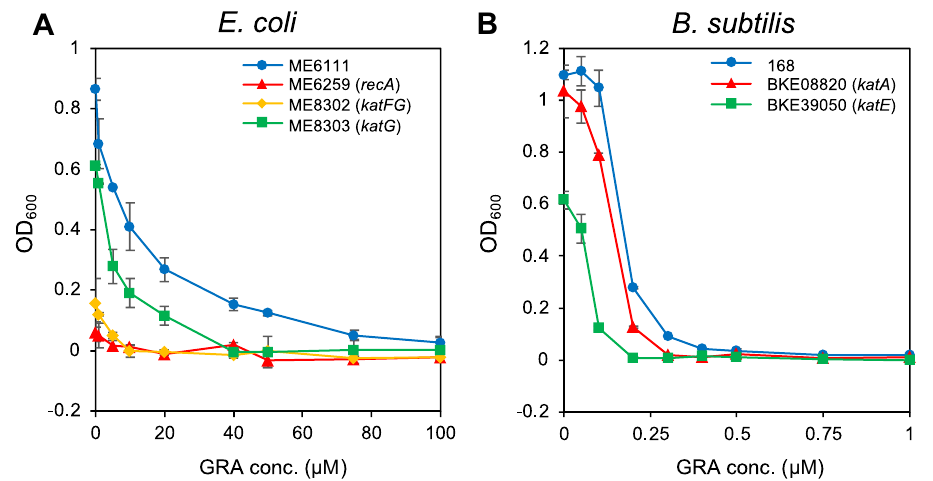
Figure 7. Inhibition of bacterial growth by granaticin. Growth inhibition of E. coli ( A ) and B. subtilis ( B ). Strains were inoculated into LB liquid medium containing various concentrations of granaticin, and the optical density at 600 nm (OD600) was measured after 5 h of cultivation. The data are the means of three measurements. The error bars represent the standard